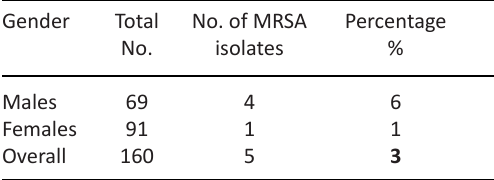
Table 5. Gender-wise prevalence of MRSA carriage